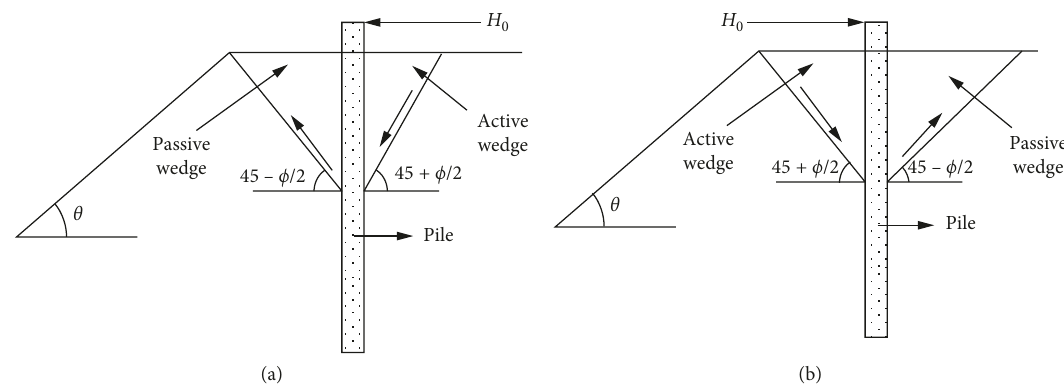
Figure 14: Failure mechanism of a pile in sloping ground. (a) Toward loading. (b) Reverse loading.